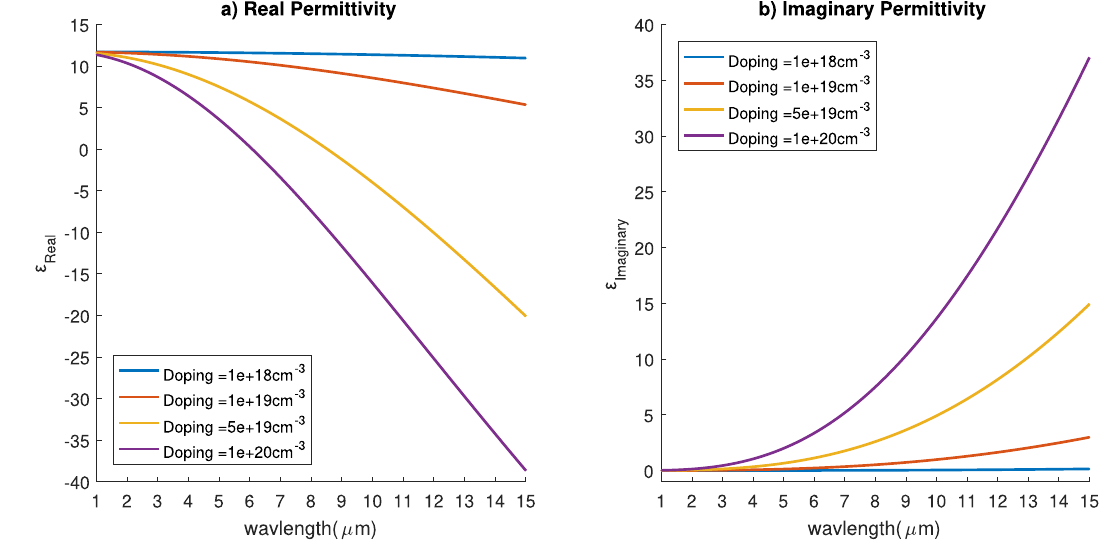
Figure 2. ( a ) Real and ( b ) imaginary parts of the permittivity of silicon at different doping concentrations.